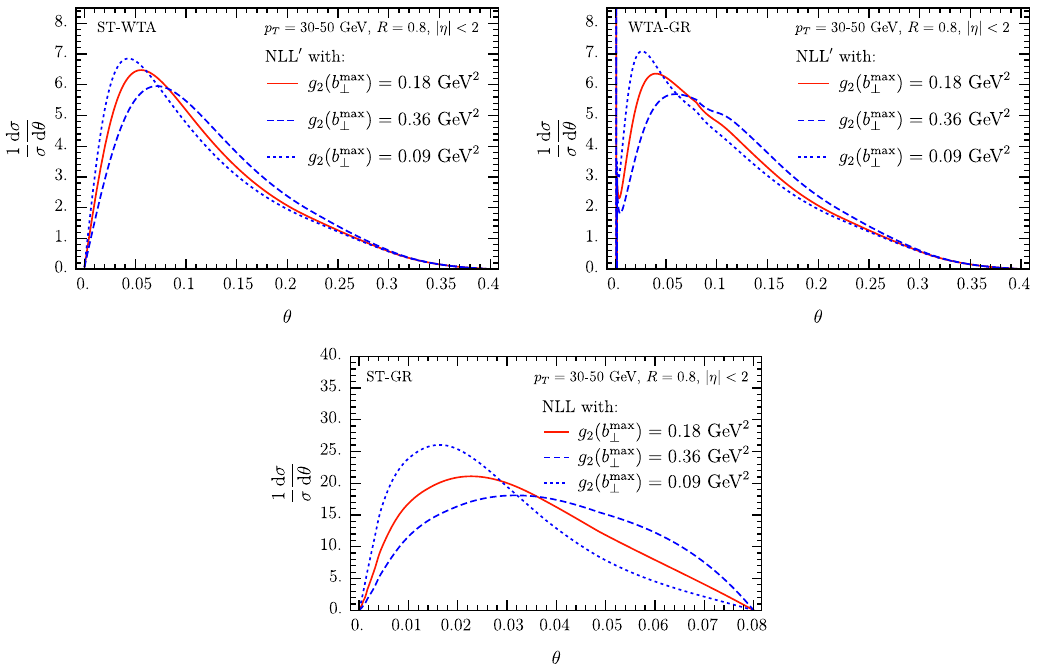
Figure 14 . The nonperturbative sensitivity of the angle between the WTA and ST axis (upper left), WTA and GR axis (upper right) and ST and GR axis (bottom), for the kinematics corresponding to the upper left panel of (cid:12)gure 7. Shown are our NLL 0 (or NLL) result with the default g 2 ( b max 0 : 18 GeV 2 (orange), as well as double (blue dashed) and half (blue dotted) this